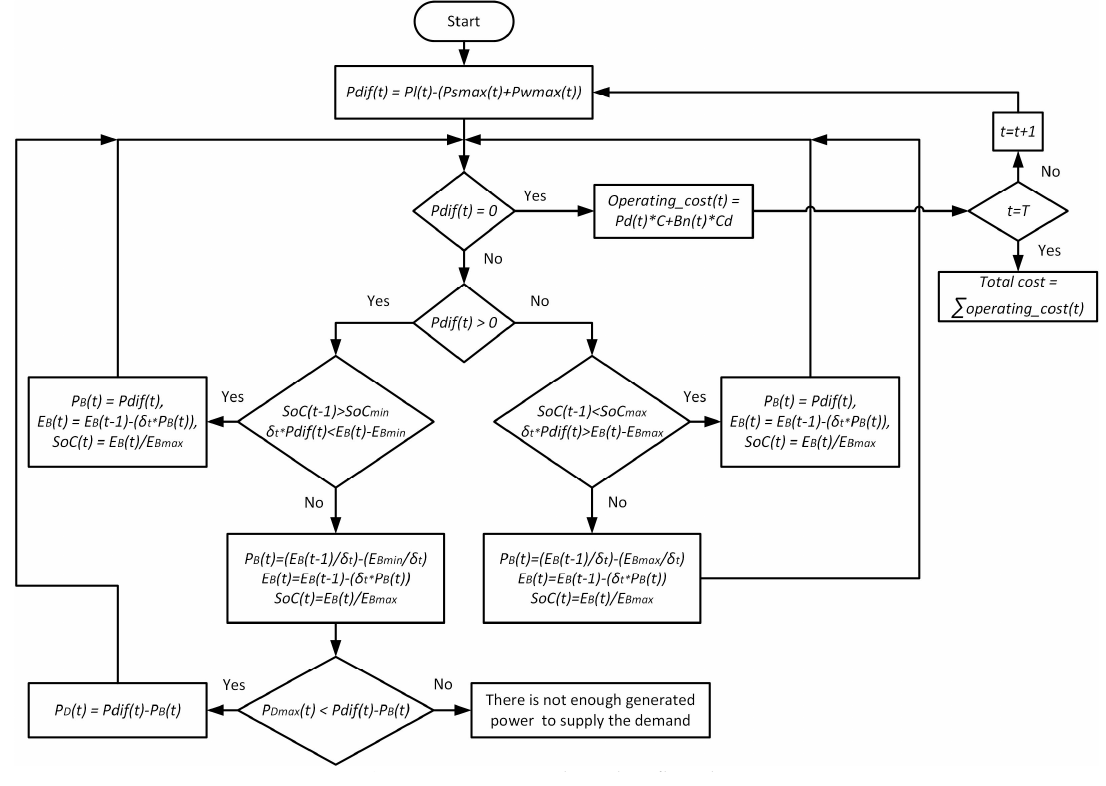
Figure 6. Heuristic algorithm flowchart.